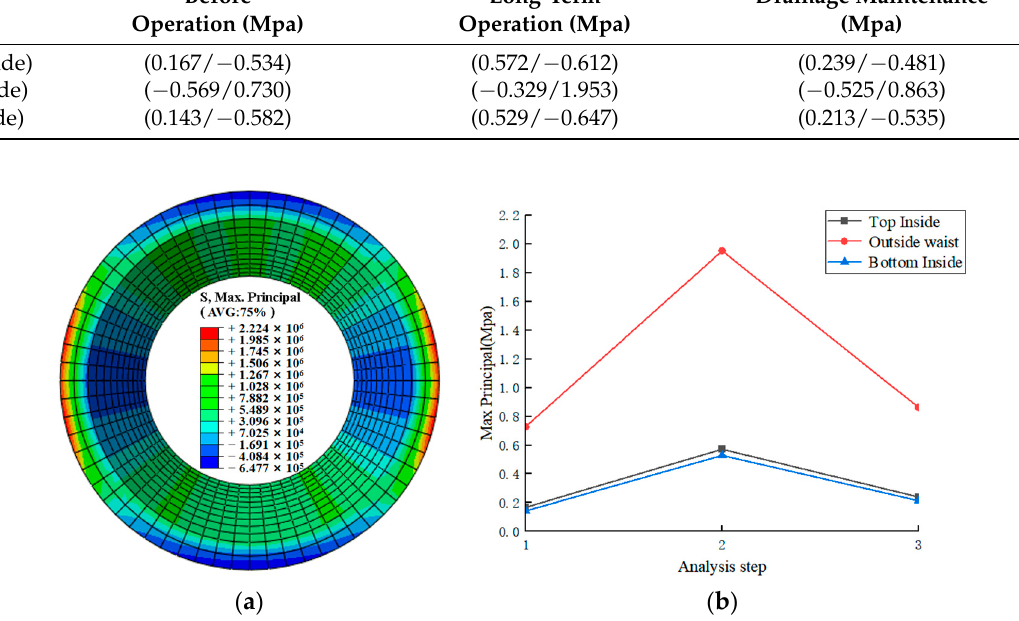
Figure 13. Stress characteristics of the segments. ( a ) Maximum principal stress of the segment. ( b ) Value of tensile part of the segment. Table 5. Maximum principal stress of the pipe